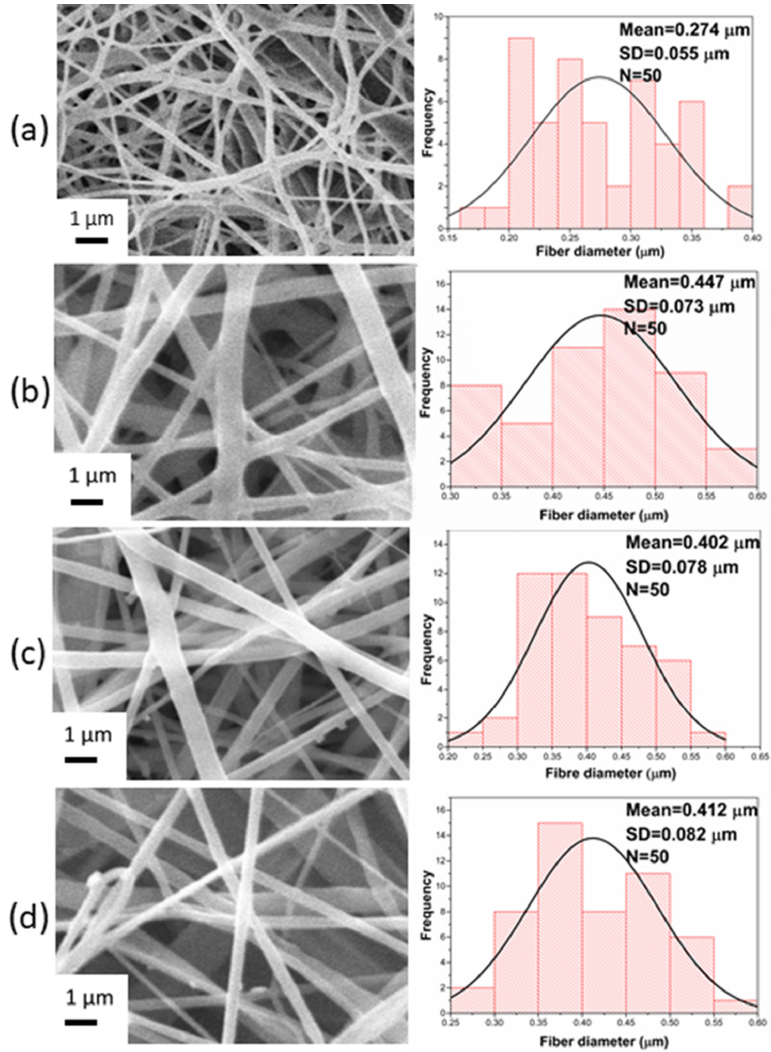
Figure 3. SEM images and bar graph of the fiber diameter distribution for the: ( a ) PCL; ( b ) PVA; ( c ) PVA:Gly; and ( d ) core-shell membranes. Table 2. Average fiber diameter and pore size of each fabricated membrane.